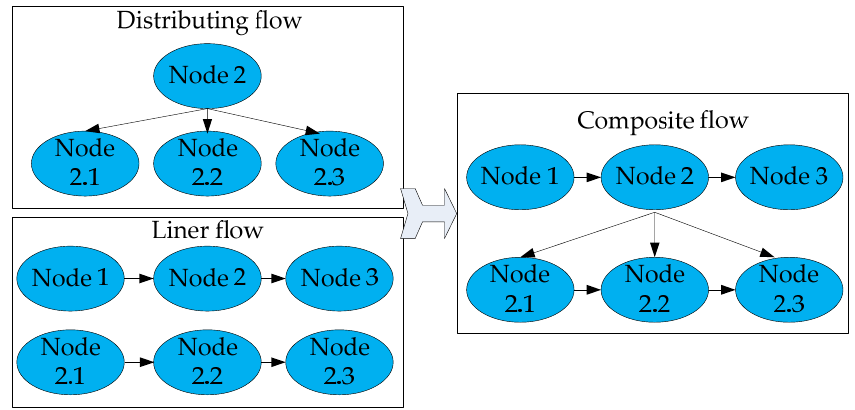
Figure 2. An example of modeling production topology.